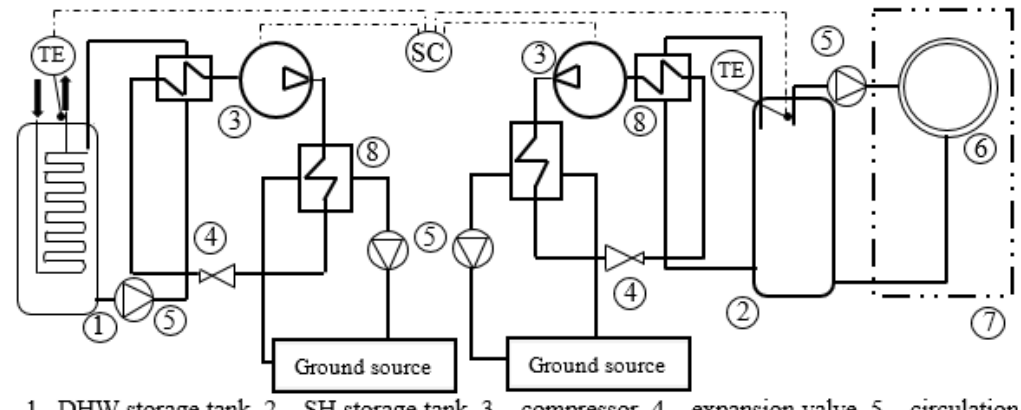
Figure 6. Schematic diagram of modeled typical domestic GSHP with an alternate operation. Figure 5. Schematic diagram of modeled typical domestic GSHP with an alternate